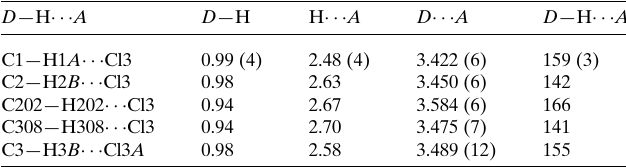
Table 4 Hydrogen-bond geometry (A˚ , (cid:3) ) for 3 .